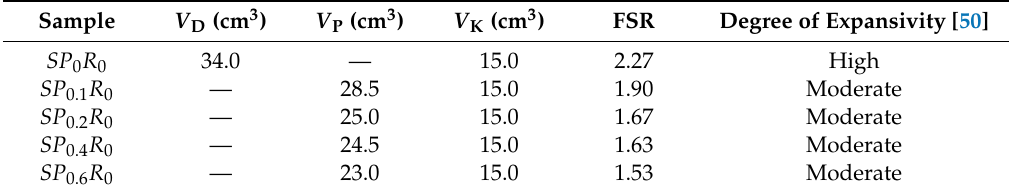
Table 5. Summary of the sediment volume features for the natural soil and various PAM-treated